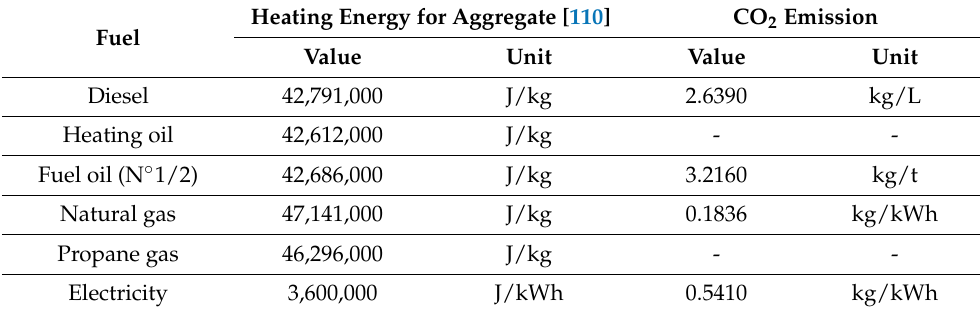
Table 4. Energy and CO 2 emission by different fuel